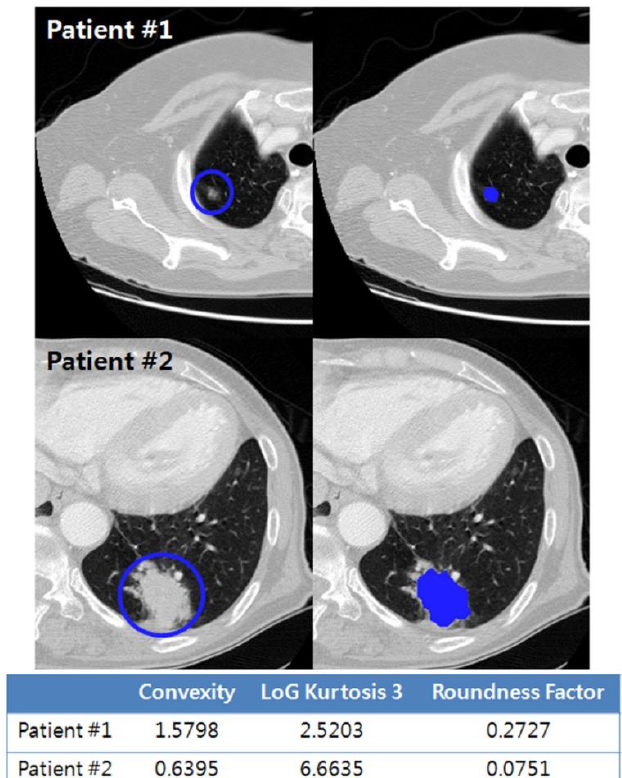
Figure 5. Representative radiomic margin characteristics were extracted from the tumor region of interest and compared between two patients with lung adenocarcinoma. Compared to patient #1, patient #2 demonstrates lower convexity, higher kurtosis, and lower roundness factor values, suggesting worse survival.